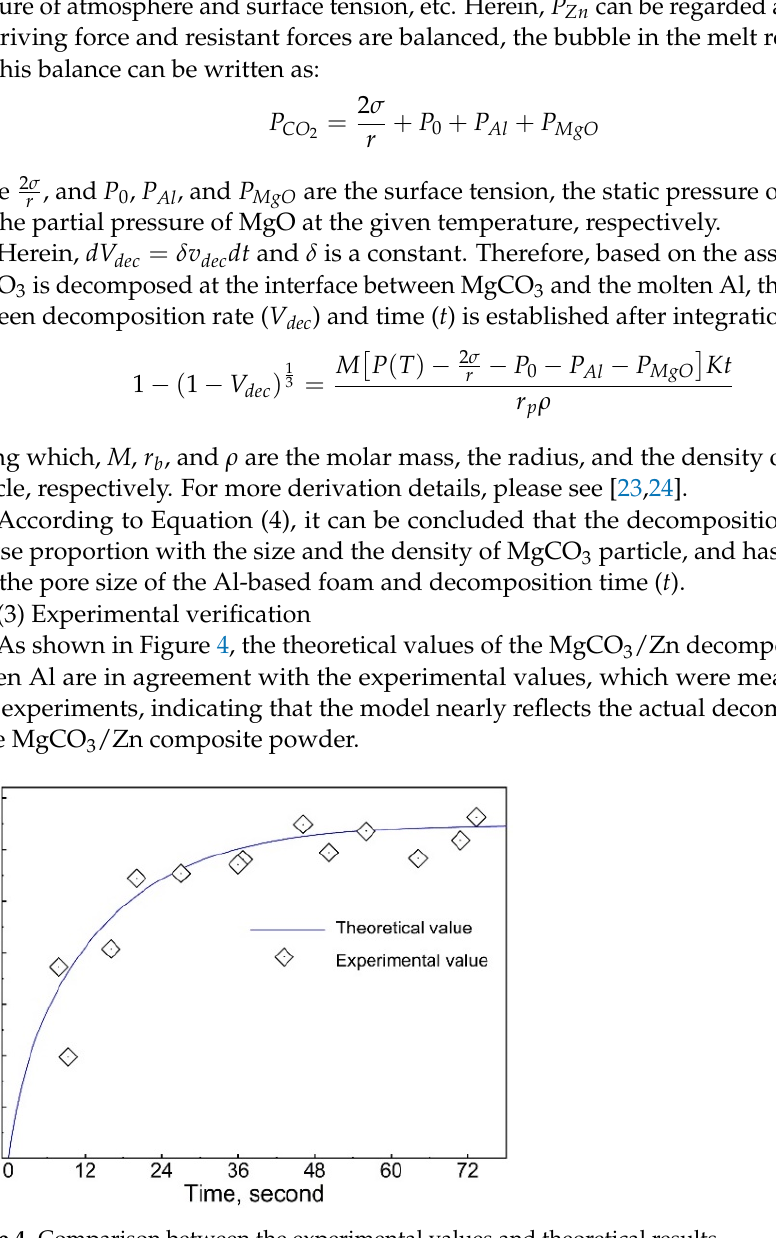
Figure 4. Comparison between the experimental values and theoretical results.